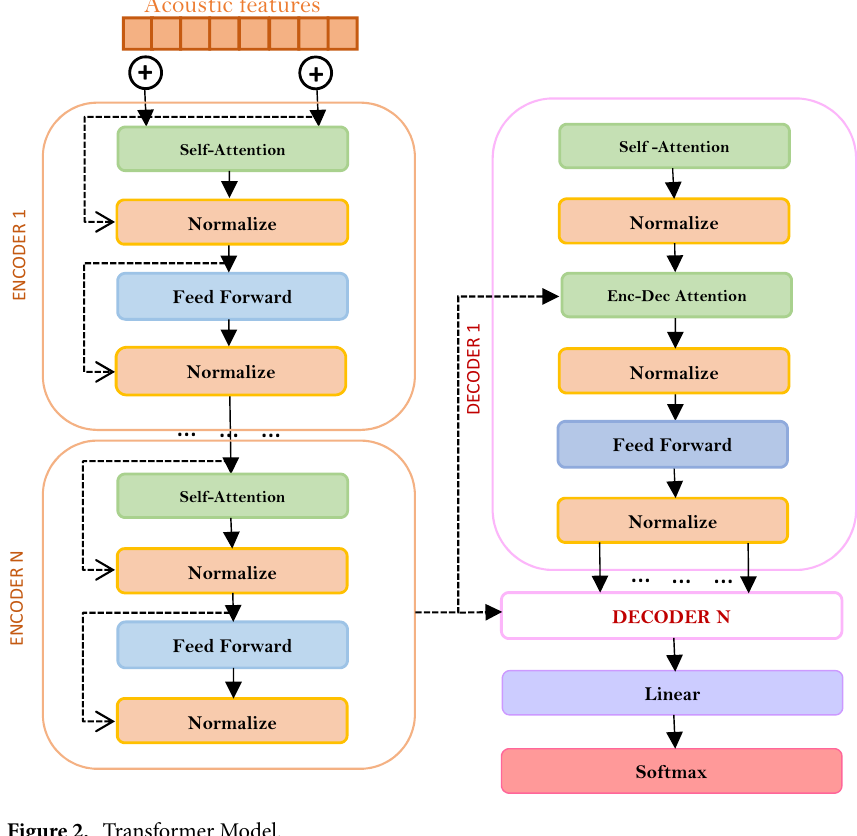
Figure 2. Transformer